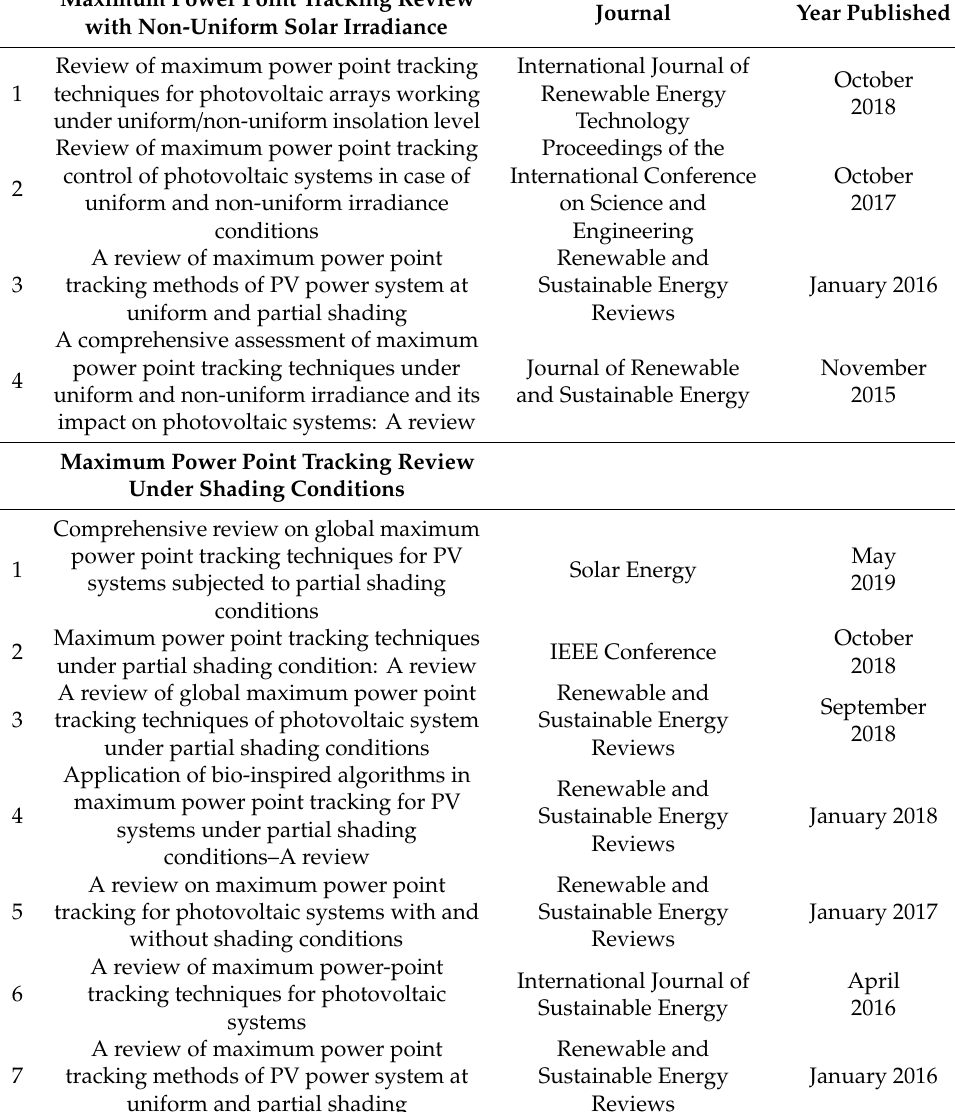
Table 1. Review papers published on maximum power point tracking over five years